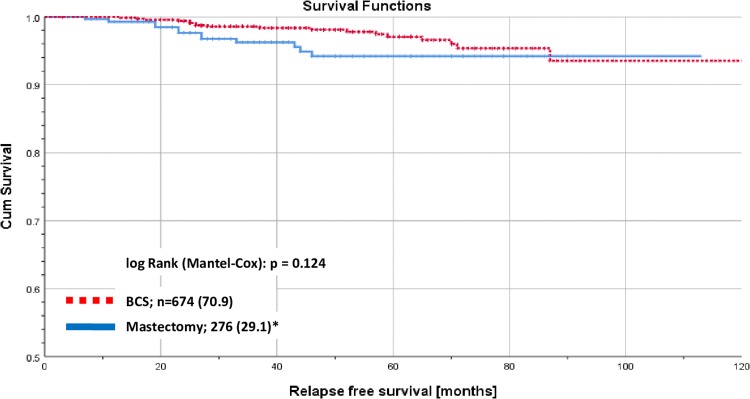
Recurrence free survival for early breast cancer patients aged ≥ 70 years.Kaplan-Meier curves of recurrence free survival for low risk early breast cancer patients aged 70 years and older stratified by BCS vs. mastectomy. Low risk: luminal A and T1/T2 and node-negative.